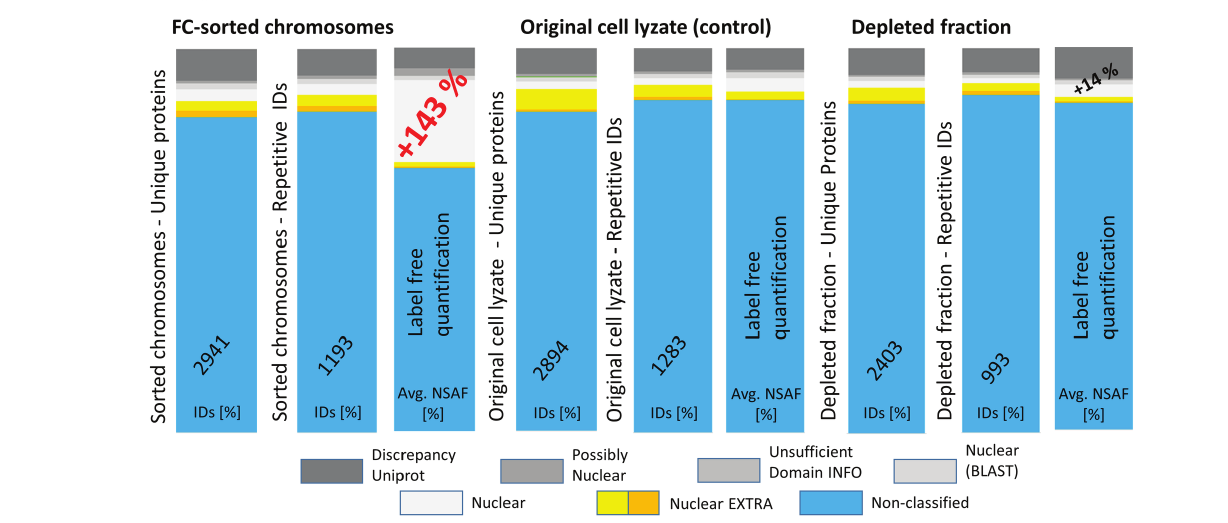
TABLE 2 | Attributes assigned to the 837 identified barley chromosomal proteins (NUCLEAR S1 + S2). Searched text string